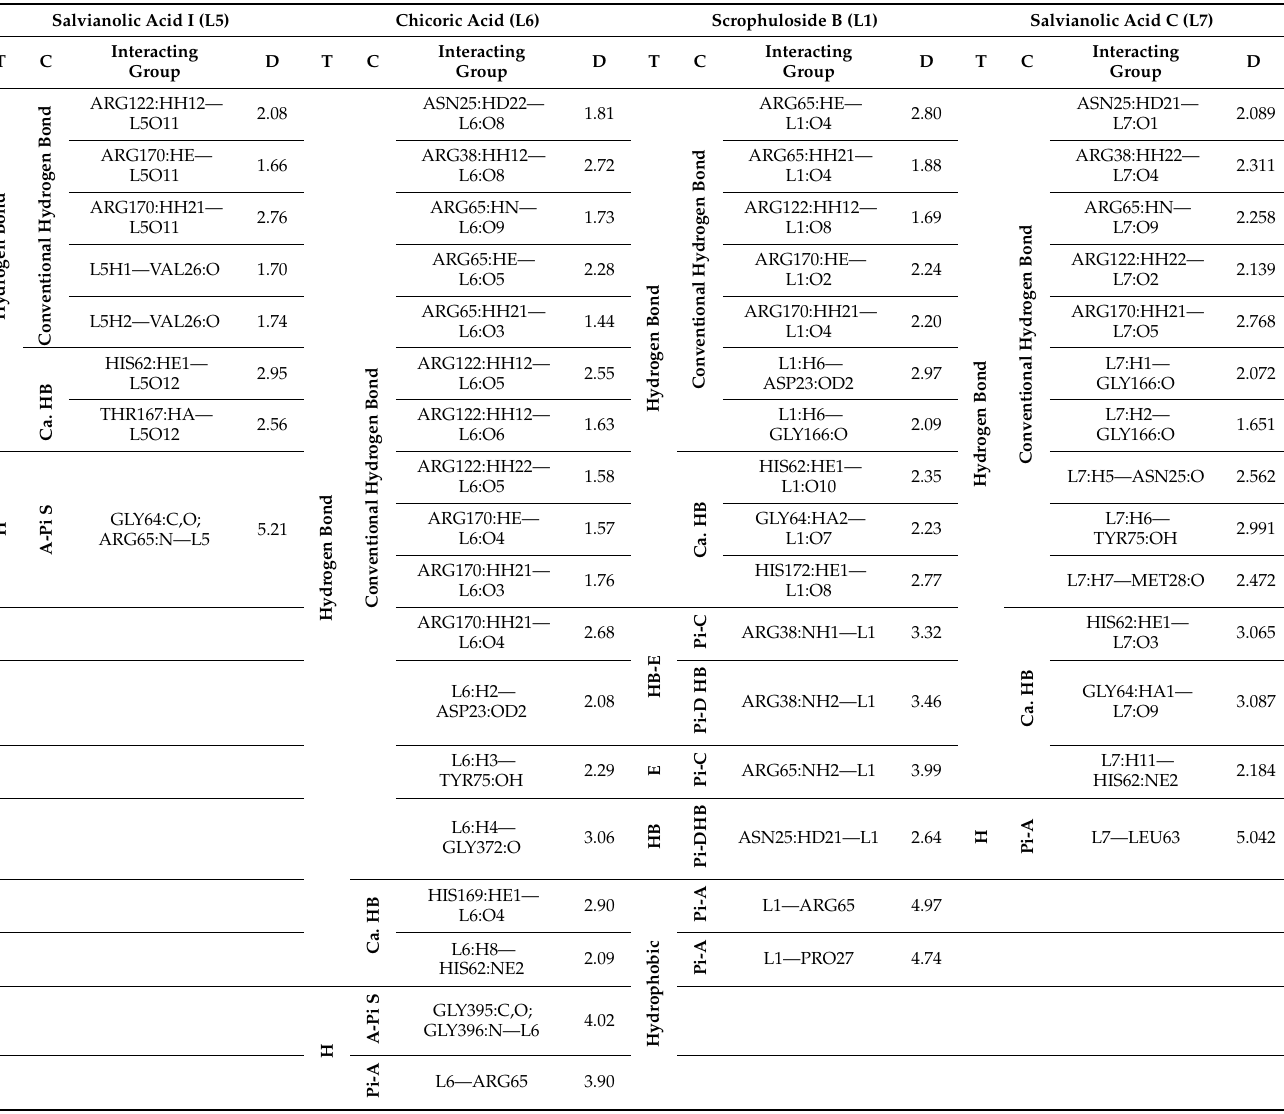
Table 3. Type of interactions and amino acids involved in the binding at the 3-Phosphoglycerate